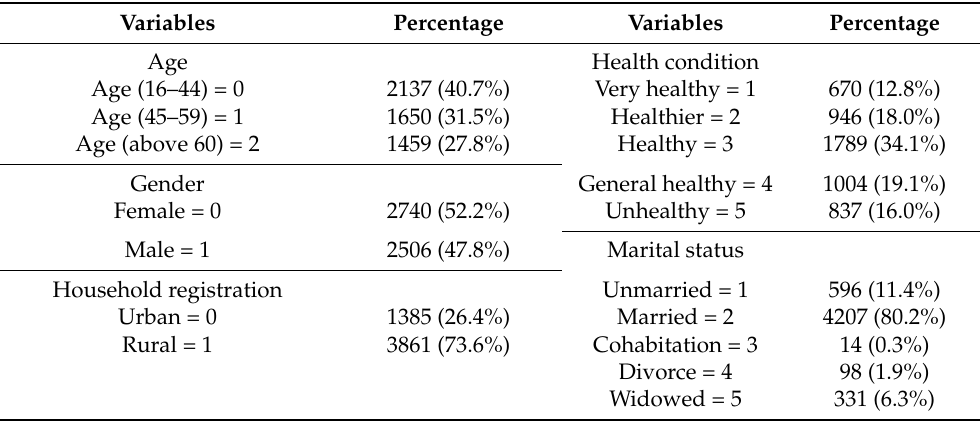
Table 1. Descriptive statistics of samples (N =